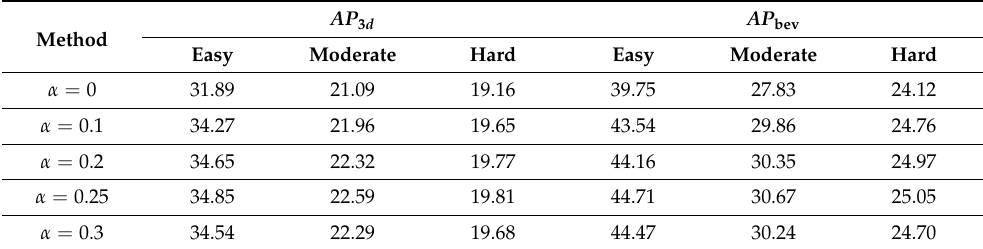
Table 5. Ablation study of auxiliary learning.